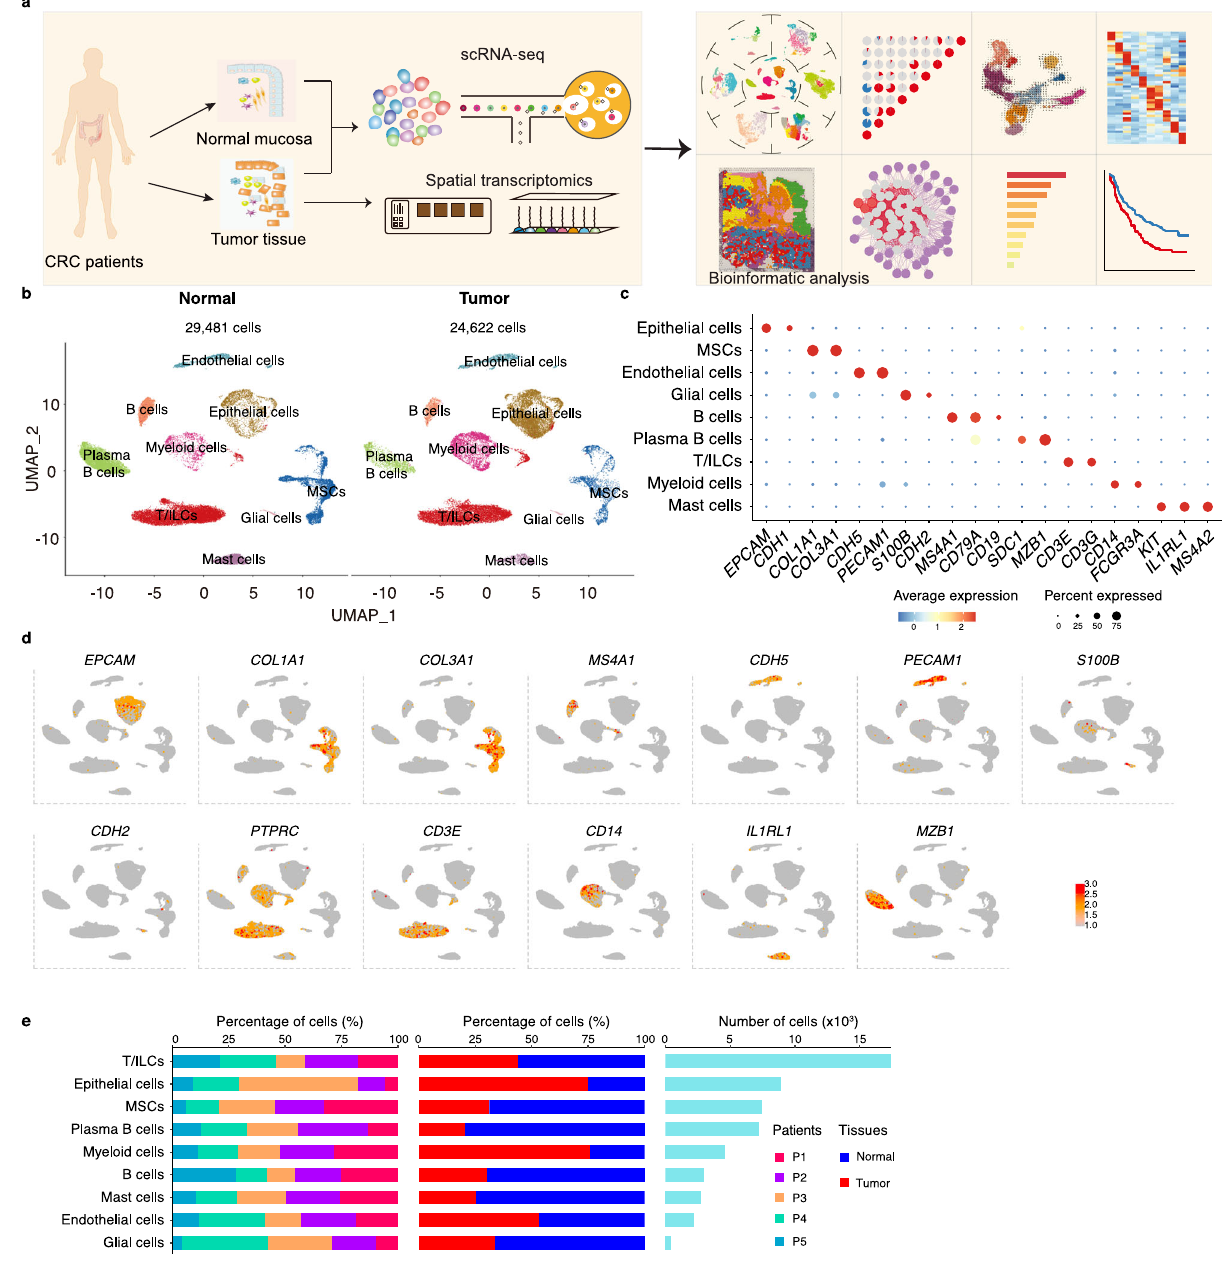
Fig. 1 Single-cell Atlas of paired human normal mucosa and CRC tissues. a Graphic overview of this study design. Normal mucosa and tumor tissue from CRC patients were processed into single-cell suspension and unsorted cells were used for scRNA-seq with 10x Genomics. Tumor slides were processed to obtain spatial transcriptomics by 10x Genomics Visium. The following integrated analysis of single-cell transcriptome data is described in squares. b UMAP plots of 29,481 cells from normal mucosa and 24,622 cells from tumor tissue of 5 CRC patients, showing 9 clusters in each plot. Each cluster was shown in different color. R package harmony was used to correct batch effects and constructed one UMAP based on all cells from adjacent tissue and tumor, and then split cells by these two tissues. c Dot plots showing average expression of known markers in indicated cell clusters. The dot size represents percent of cells expressing the genes in each cluster. The expression intensity of markers is shown. d Expression levels of selected known marker genes across 54,103 unsorted cells illustrated in UMAP plots from both normal and tumor tissue in CRC patients. e Proportion of 9 major cell types showing in bar plots in different donors (left panel), tissues (middle panel), and total cell number of each cell type (right panel) are shown. CRC, colorectal cancer. Source data are provided as a Source data Fig. 1b –